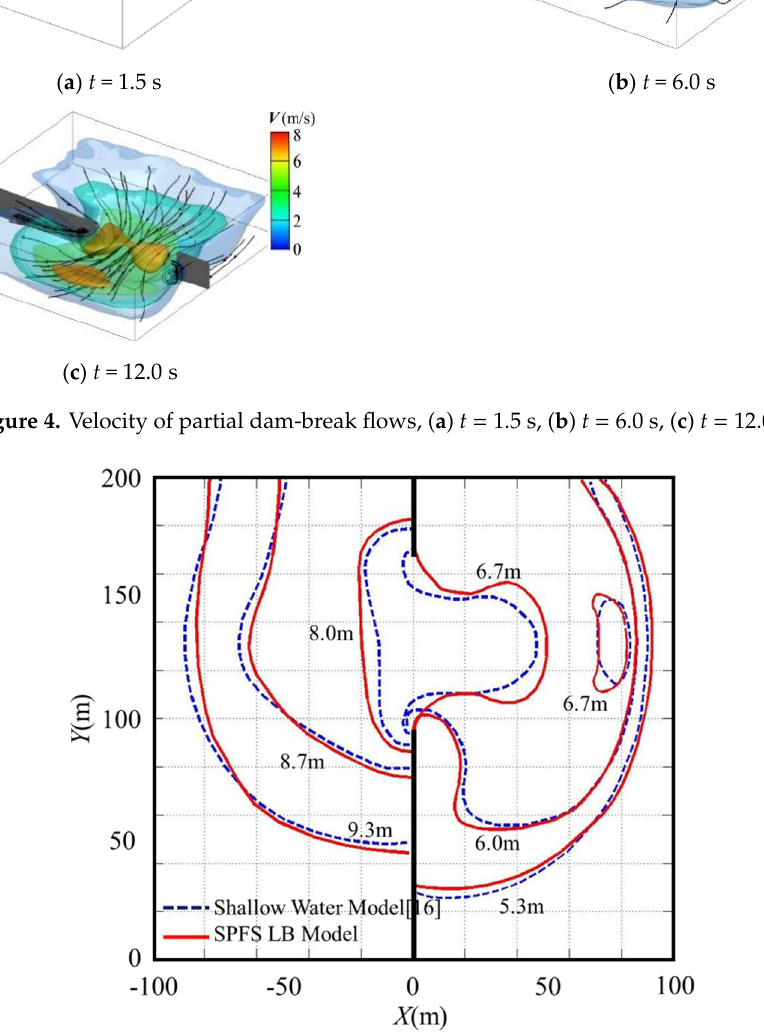
Figure 5. Contour of partial dam-break flows at t = 10.1 s.